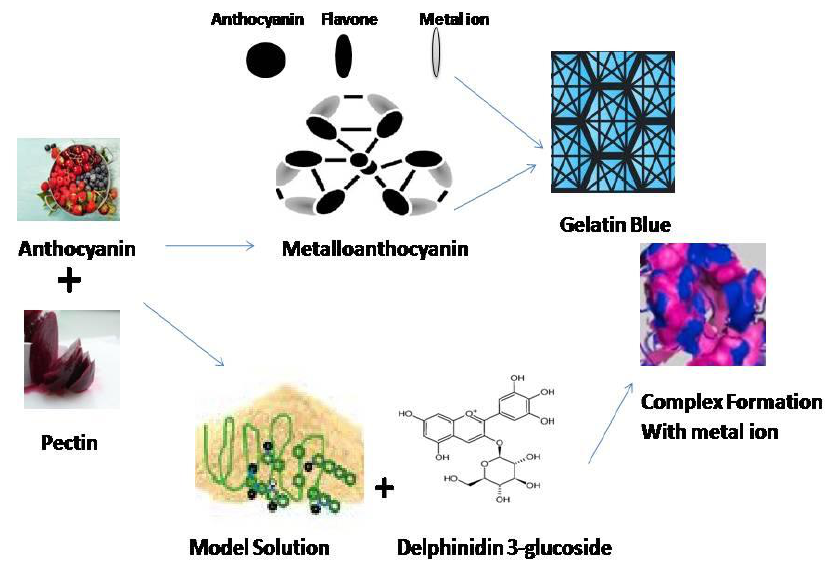
Figure 3. Pictorial representation showing the interaction of polysaccharide-based wall material (pectin) with the ACNs color pigments as encapsulating agents to increase the stability of ACNs.